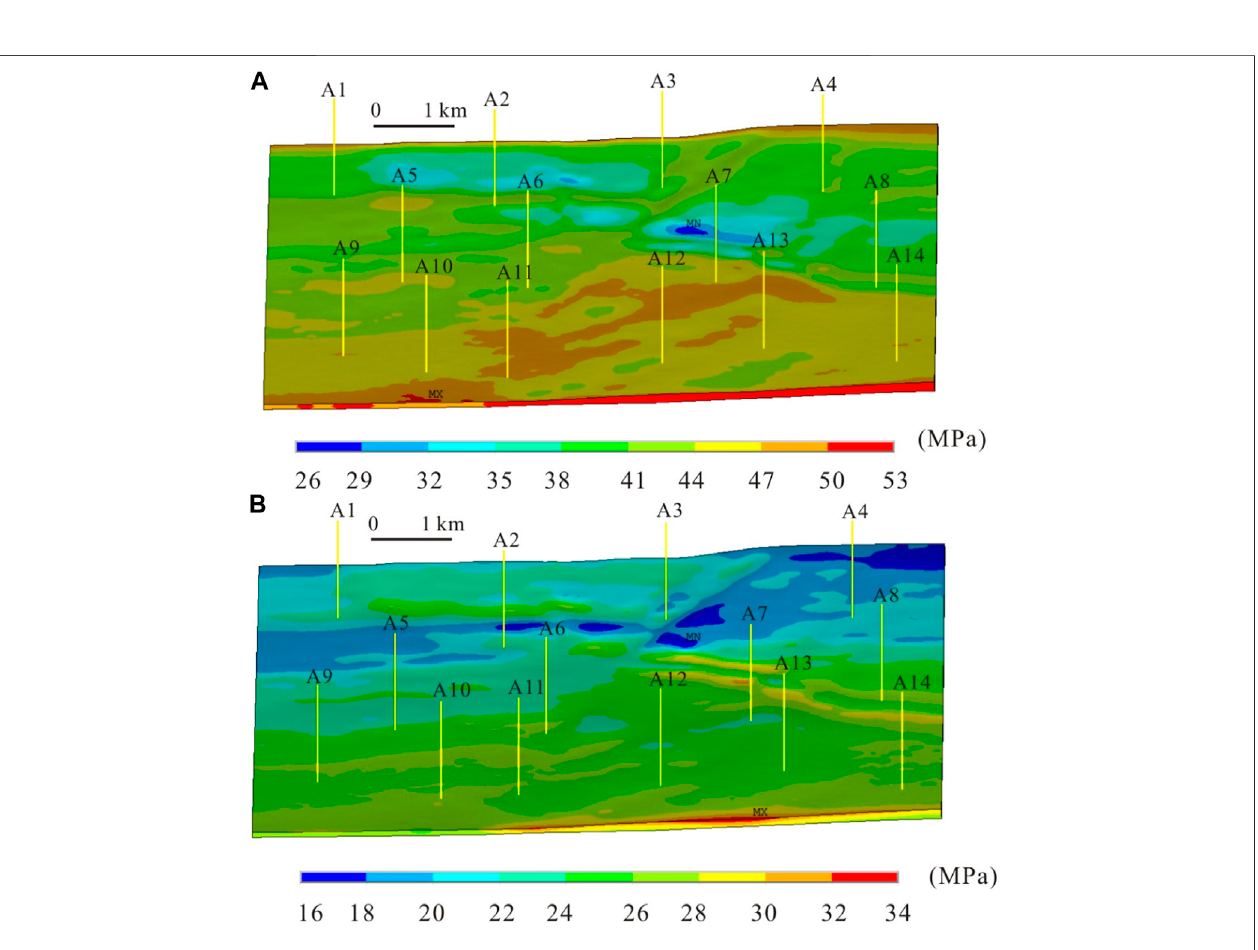
Frontiers in Earth Science |